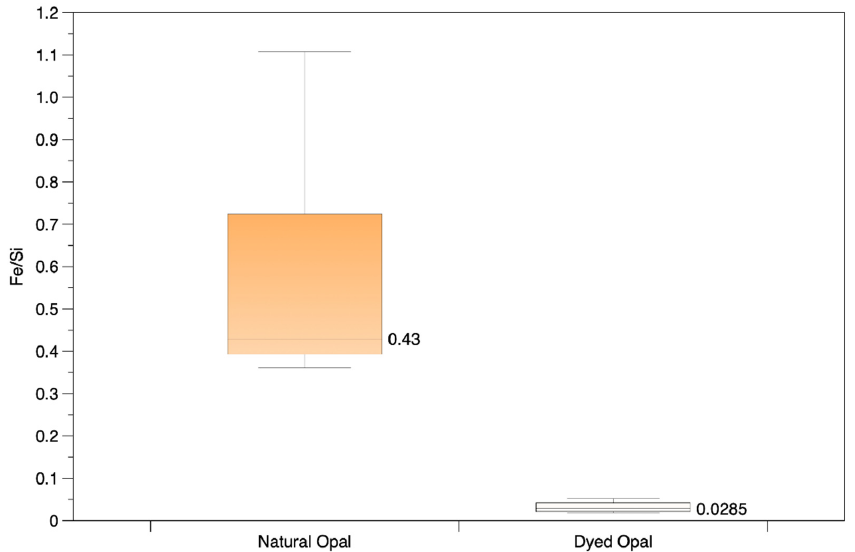
Figure 12. Fe/Si count ratio of the opal samples: there is a wide difference (more than 15-fold) in the Fe content between natural (mean value 0.43) and treated samples (mean value 0.0285).